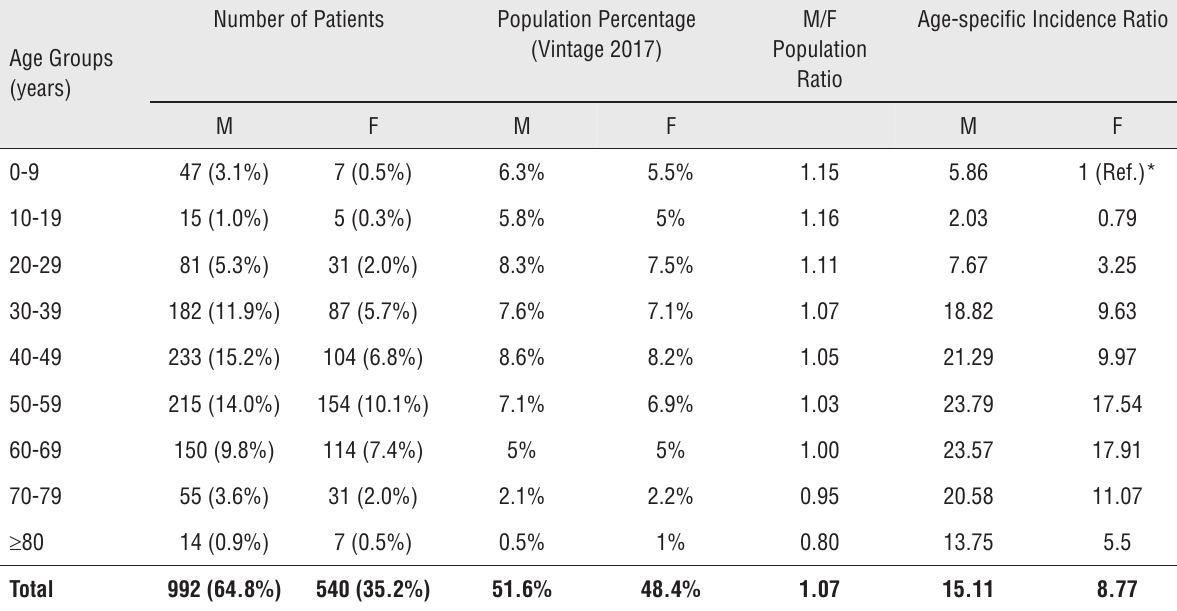
Table 2 - Age-specific prevalence ratios adjusted by the population of China census in 2017.